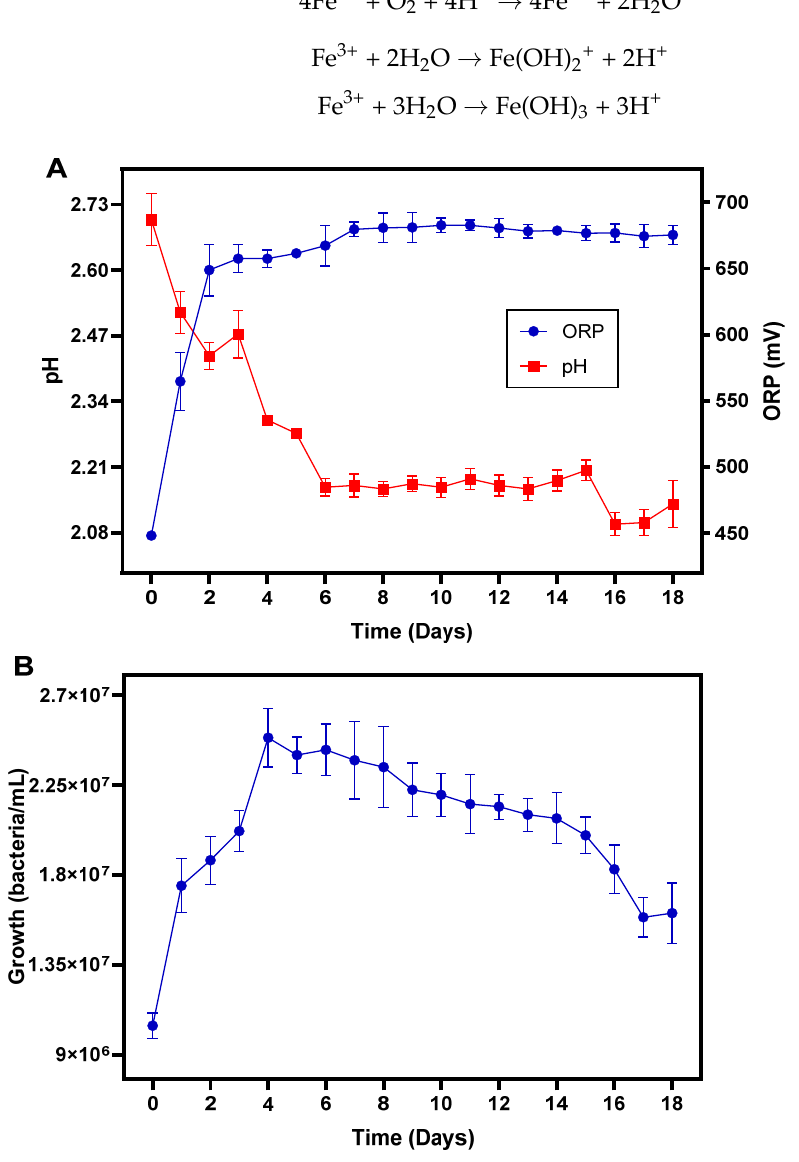
Figure 7. Variation of ( A ) pH and oxidation-reduction potential (ORP) and ( B ) growth of the bacterial consortium, during the bioleaching of PCBs waste.